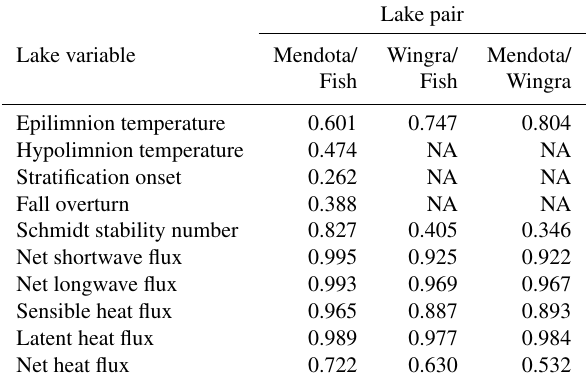
Table 5. Correlation coefficients for lake pairs of simulated open- water lake variables. NA indicates data that are not